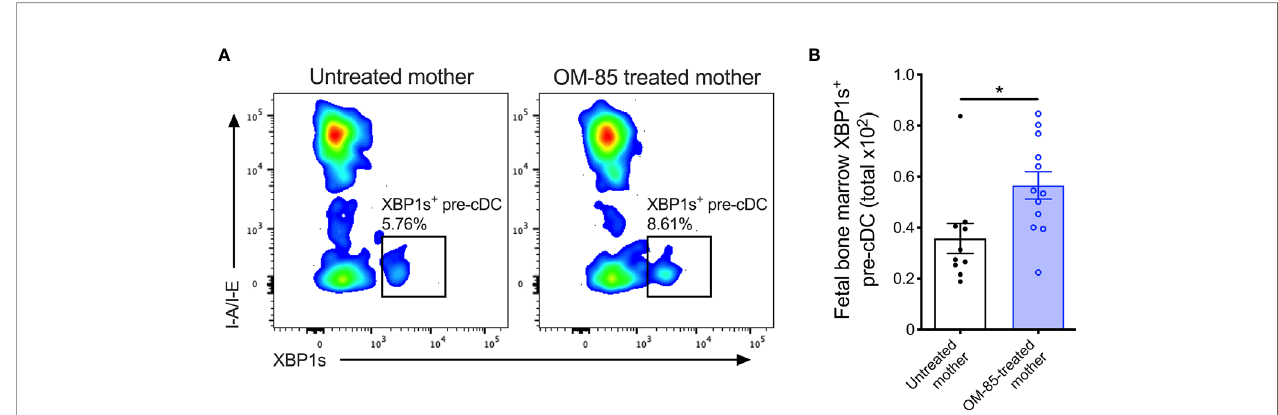
FIGURE 4 | XBP1s expression in pre-cDCs within fetal bone marrow. (A) Representative fl ow cytometry plots demonstrating intracellular XBP1s expression in CD11b + B220 - CD11c + Gr-1 - I-A/I-E - XBP1s + pre-cDC within fBM. (B) Absolute numbers of XBP1s + pre-cDC in BM of fetuses from OM-85-treated and untreated mothers. Data are presented from individual animals comparing fetuses from OM-85-treated and untreated mothers and displayed as bar graphs showing mean ± SEM of n = 4 independent experiments, with each experiment containing fetuses from 1 untreated and/or 1 OM-85 treated mother. Statistical signi fi cance was determined using Mann-Whitney U test. *p <